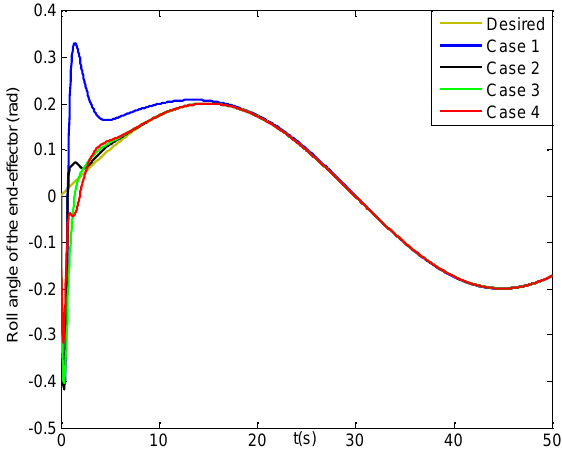
Figure 9. Roll angles of the end − effector (four cases).